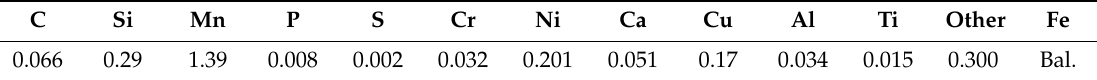
Table 1. Chemical composition of the X70 steel specimens (wt